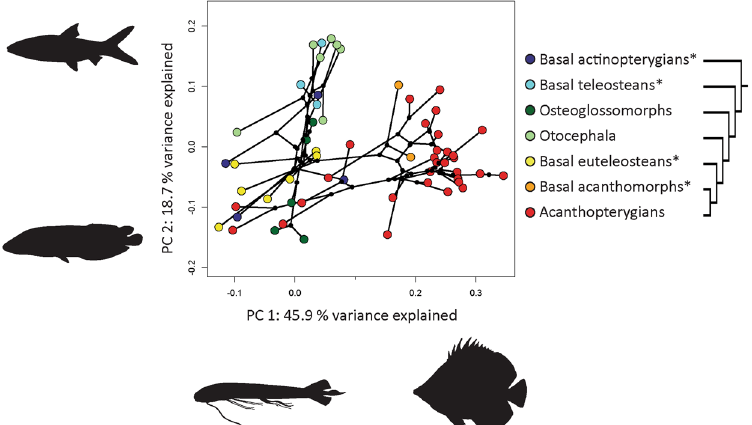
Figure 1. Phylomorphospace analysis of the body shape of 58 actinopterygian species. Fish silhouettes represent the most extreme forms along the first and second axes of the PCA. The simplified phylogeny summarizes the molecular phylogenetic hypothesis from Near et al . 50 . Groups marked with an asterisk are the basal members of their respective clades and are thus paraphyletic.